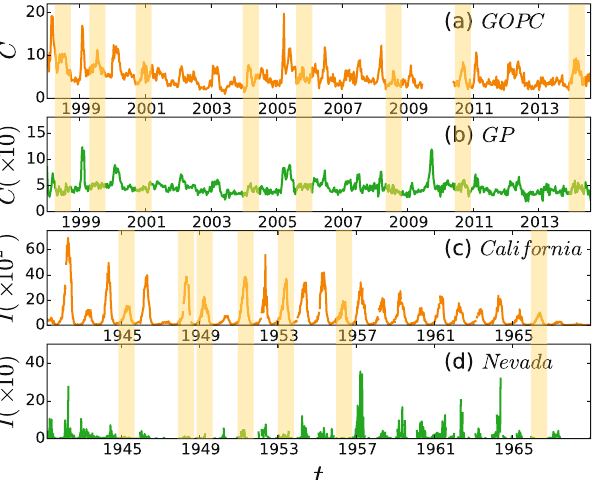
Figure 1. Time series of recurrent epidemics in two coupled regions or cities. ( a ) and ( b ) represent the weekly consultation rates of influenza-like illness (per 1000 consultations) from 1998 to 2014 in Hong Kong for the General Out-Patient Clinics (GOPC) and the General Practitioners (GP), respectively, where the data from 2009/6/13 to 2010/5/23 in ( a ) are not available and the value of C in ( b ) is from 0 to 150. ( c ) and ( d ) represent the time series of reported weekly measles infective cases I in California and Nevada,